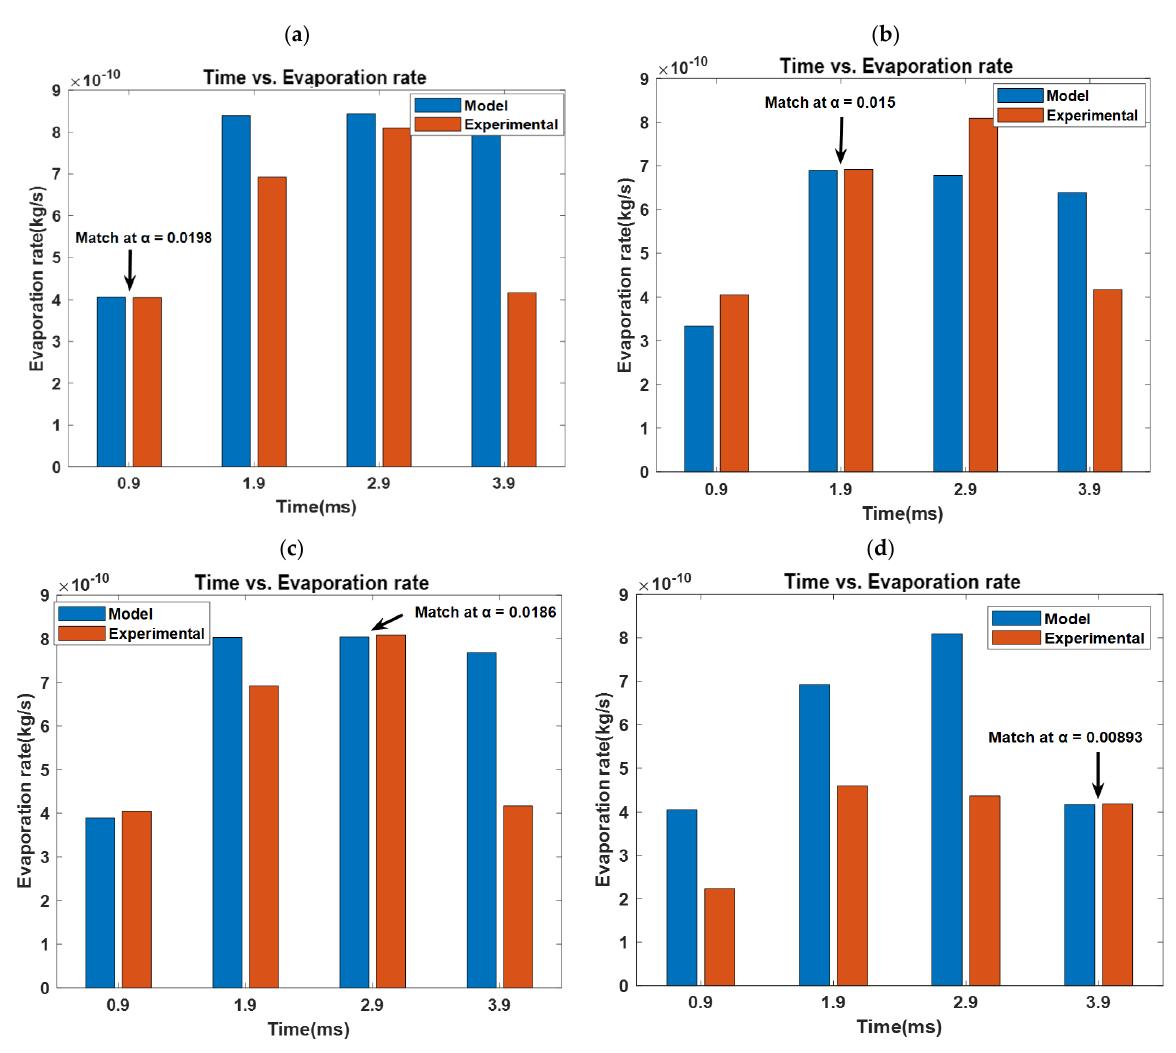
Figure 13. A comparison between the evaporation rates of the model and experimentally derived wall heat flux at various times of 0.9 ms ( a ), 1.9 ms ( b ), 2.9 ms ( c ), and 3.9 ms ( d ). The accommodation coefficient could be estimated through iterative matching. The results suggest that the matched coefficient reduces with